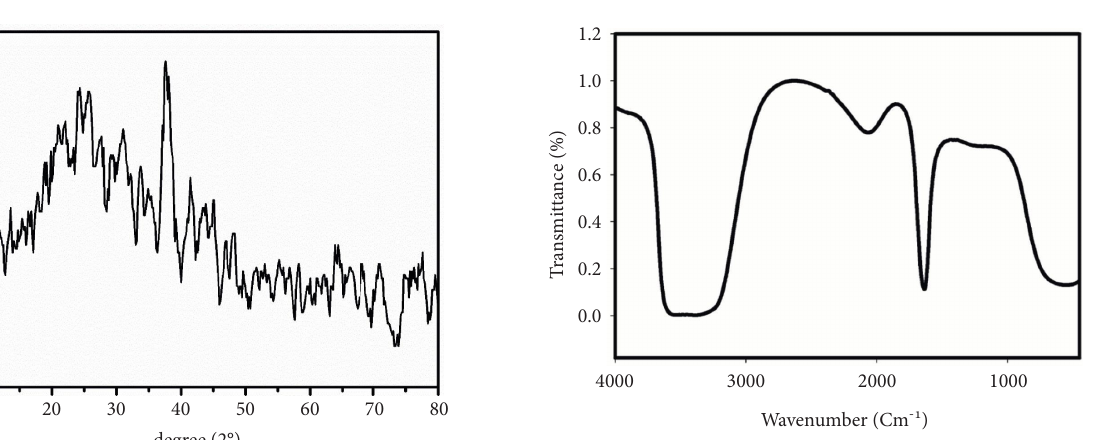
Figure 5: Fourier-transform infrared spectroscopic data of silver nanoparticles biosynthesized by Cystoseira myrica .